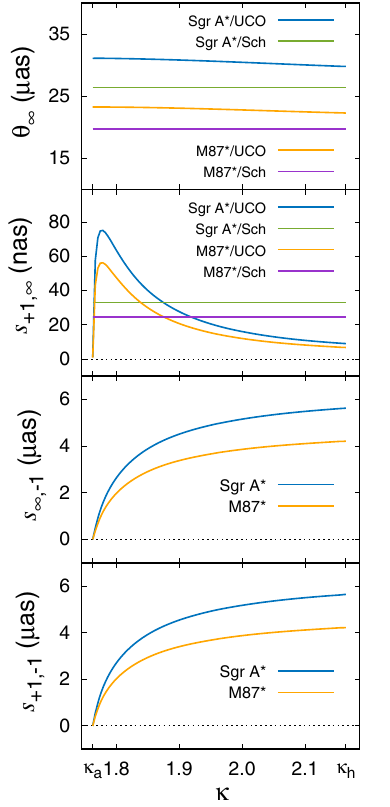
Fig. 3 The angular observables, the apparent radius of the photon sphere θ ∞ as well as separation between relativistic images s + 1 , ∞ , s ∞ , − 1 and s + 1 , − 1 , are shown from top to bottom panels. When appli- cable, these observables for the ultracompact object (UCO) and for the Schwarzschild black hole (Sch) are both